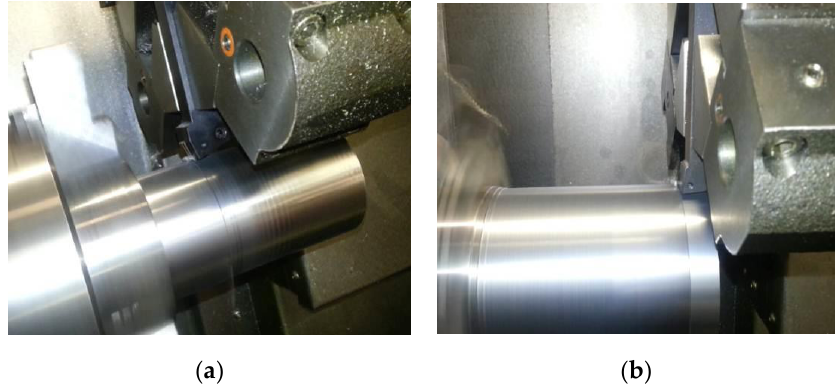
Table 1. The geometry of used tools.